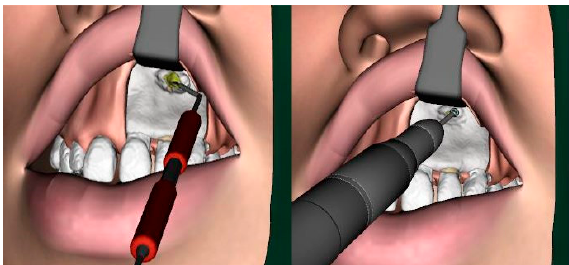
Figure 3. The virtual intraoperative situation while drilling the root tip cavity and removing infected (yellow) tissue with a surgical spoon.